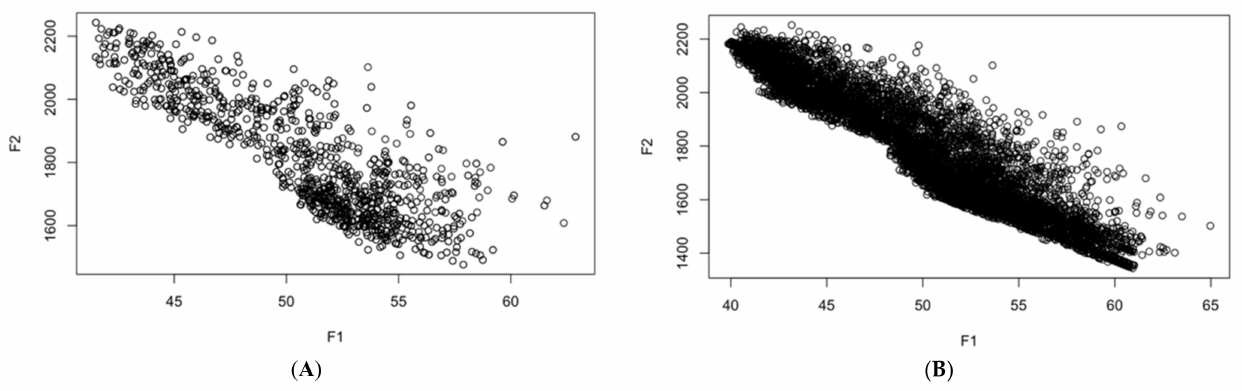
Figure 9. Image set of all obtained solutions considering all executions of the evolutionary algorithms for the contingent phase presented in Equation (6). ( A ) NSGA-II, ( B )